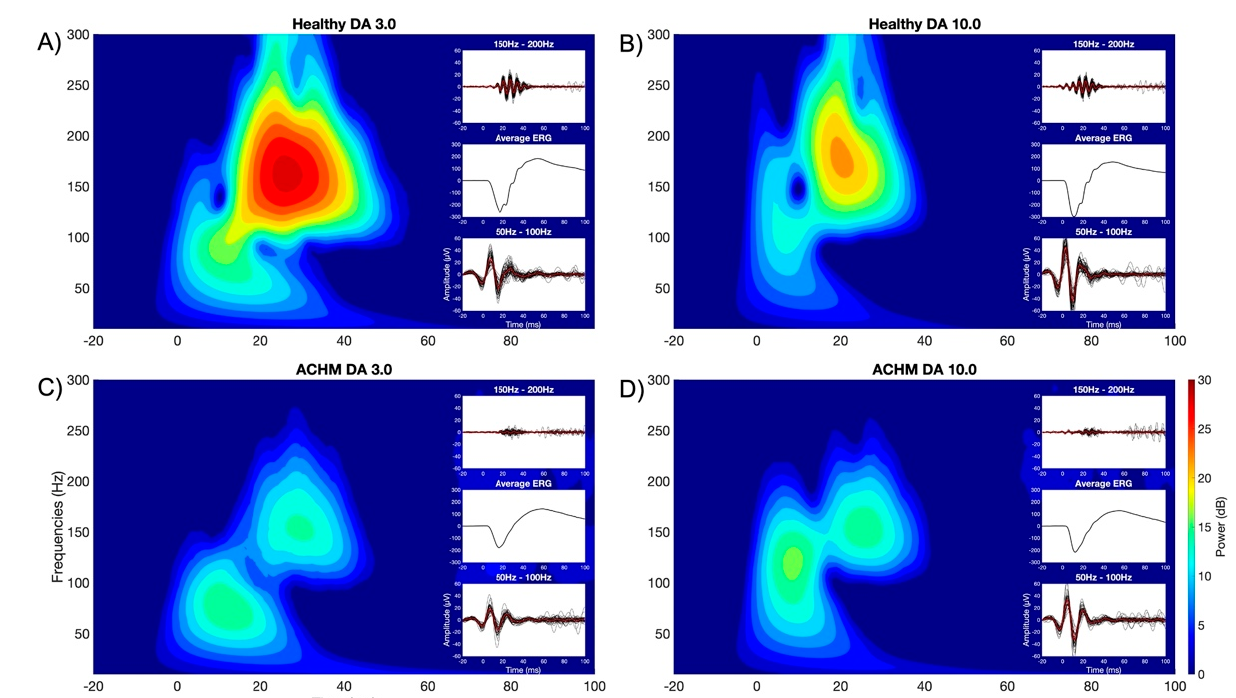
Figure 2. Time − frequency maps on the left indicate relative power (dB) under the DA 3.0 condition for healthy individuals ( A ) and ACHM ( C ). Time − frequency maps on the right indicate relative power (dB) under the DA 10.0 condition for healthy individuals ( B ) and ACHM ( D ). The traces depicted on the right side of each map represent the ffERG signal. From top to bottom, these traces represent: the ffERG trace filtered at 150–200 Hz (individual traces in black and the group average in red), the group average ERG trace, and the ERG trace filtered at 50–100 Hz (individual traces in black and the group average in red). To be noted in both DA 3.0 and DA 10.0 conditions, there is a considerable reduction in the signal in the filtered ffERG trace (150–200 Hz) of achromats compared to healthy controls, which is also reflected in the average ffERG.